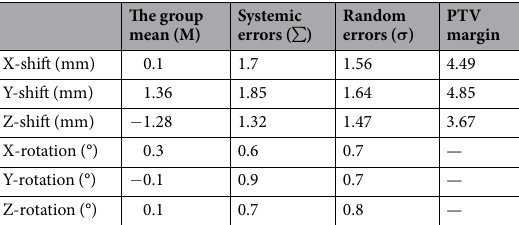
The group mean (M)